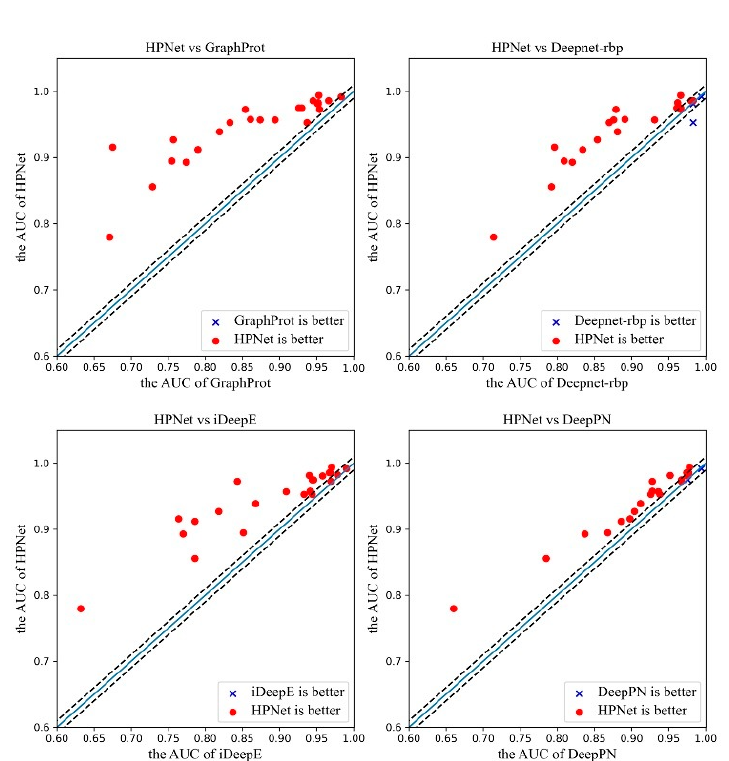
Figure 4. Comparison of the areas under the curve (AUCs) of HPNet and four methods with the debiased dataset.